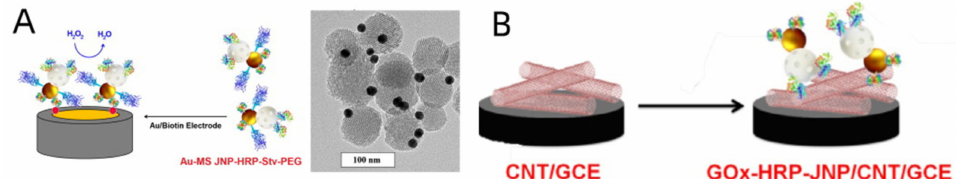
Figure 7. ( A ) Au MS JNPs dually functionalized with HRP and Stv and polyethylenglycol chains used as a biorecognition signaling system or GOx and HRP enzymes as electrode modifiers for affinity and catalytic electrochemical biosensing, respectively. Reprinted with permission from ref.